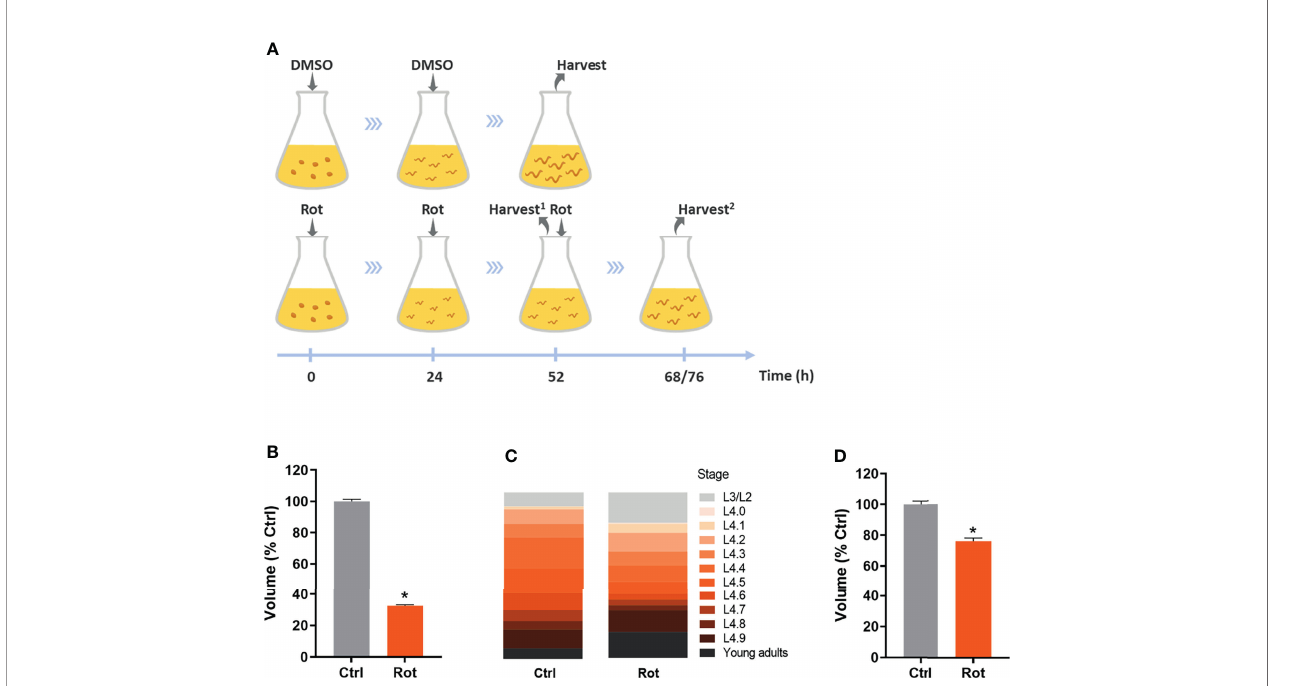
FIGURE 2 | Rotenone impairs C. elegans growth and development. Solvent control (Ctrl) and rotenone-exposed (Rot) nematodes were assessed for size and developmental stage as described in the methods. (A) Representative image of the exposure design: dimethyl sulfoxide (DMSO) and 0.5 µM rotenone solutions containing 0.125% DMSO were added at the indicated time points and nematodes were harvested when most of the animals were at the L4 larval stage (Harvest2) for all the assays, except for results shown in Figure 1B , where animals were harvested at the same time point as the control animals (52 h; Harvest1) (see methods for further details). (B) Volume of nematodes exposed to rotenone for 52 h compared to solvent control (% Ctrl). (C) Sub-stage distribution and (D) volume of Ctrl and Rot-treated animals after L4 stage synchronization. * represents signi fi cant difference (p < 0.05) compared to